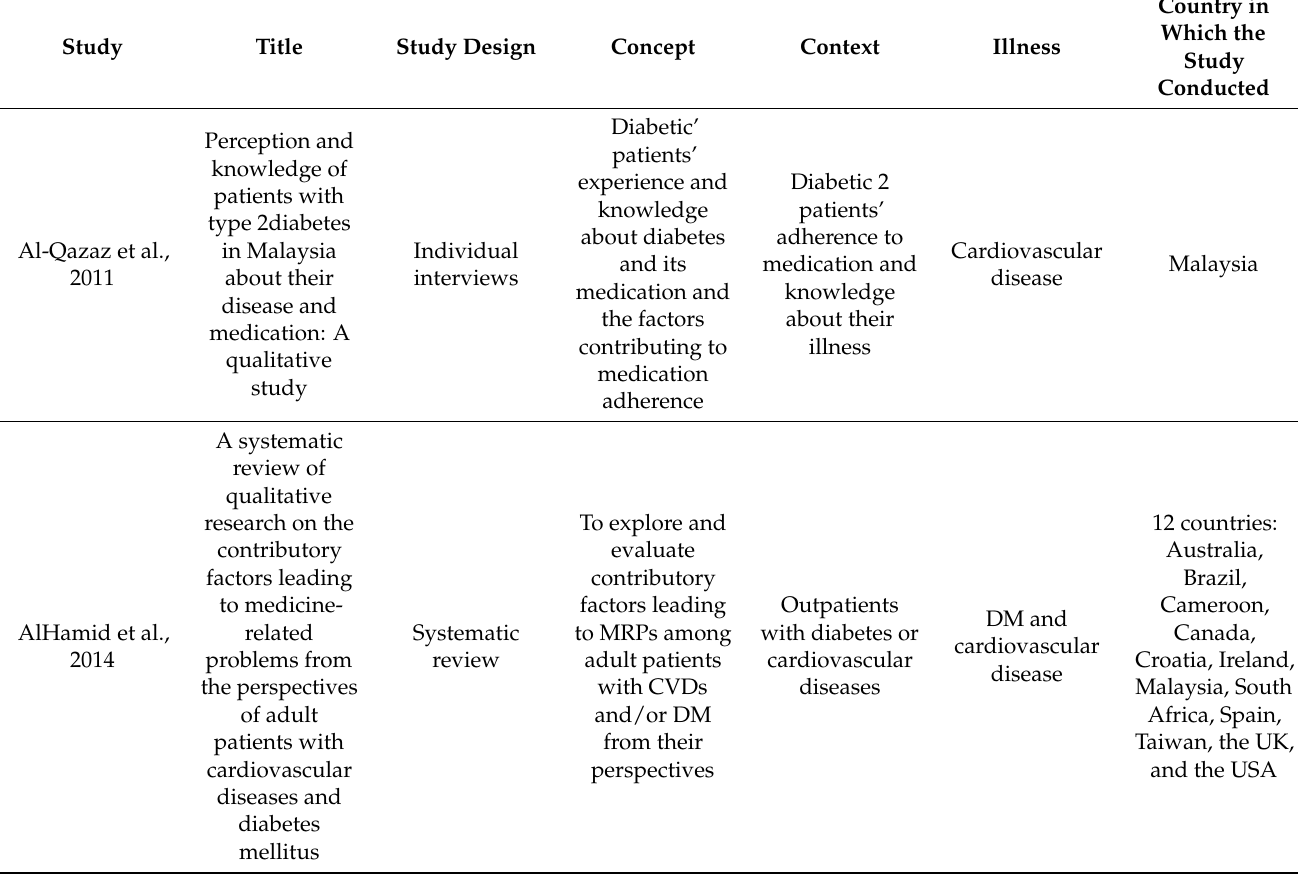
Table A1. Summary of included